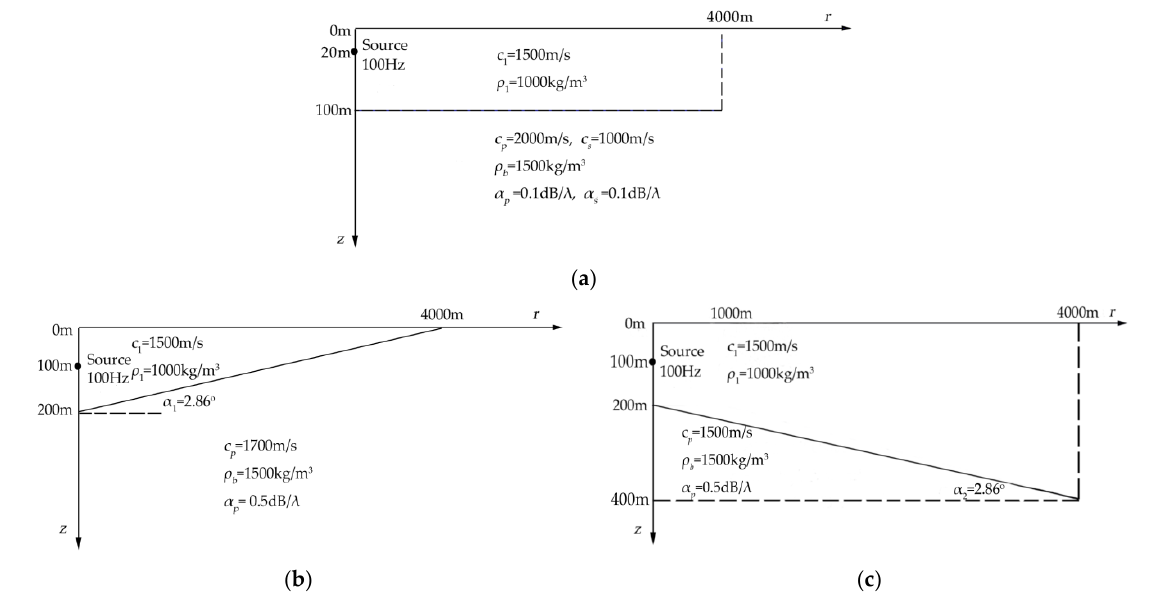
Figure 2. The simulation conditions and schematic diagrams of three types of shallow water models in comparison. ( a ) A shallow water environment with horizontal sea bottom; ( b ) a shallow water environment with wedge-shaped uphill sea bottom; the sea water depth is decreased linearly from 200 m at 0 km to 0 m at 4 km at a 2.86 ° slope angle ; ( c ) a shallow water environment with wedge-shaped downhill sea bottom; the sea water depth increases linearly from 200 m at 0 km to 400 m at 4 km also at a 2.86° slope angle.